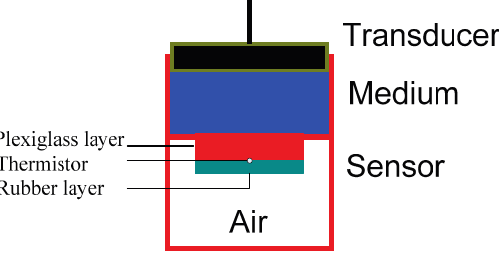
Figure 2. The structure of the two-layer thermoacoustic